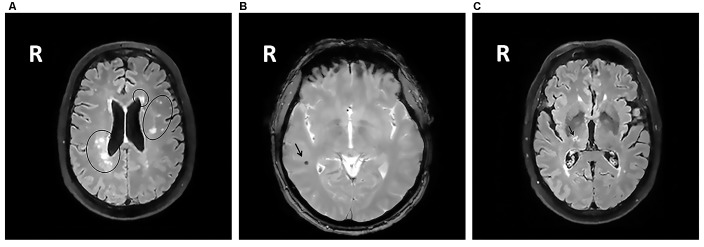
(A) Fluid-attenuated inversion recovery (FLAIR) brain magnetic resonance imaging (MRI) scan showing periventricular WMHs and deep WMHs (DWMHs) in both hemispheres. WMH, white matter hyperintensities; R, right. (B) T2*-weighted brain MRI scan showing a microbleed located within the right white matter. R, right. (C) FLAIR brain MRI scan showing a lacune located in the deep gray matter. R, right.